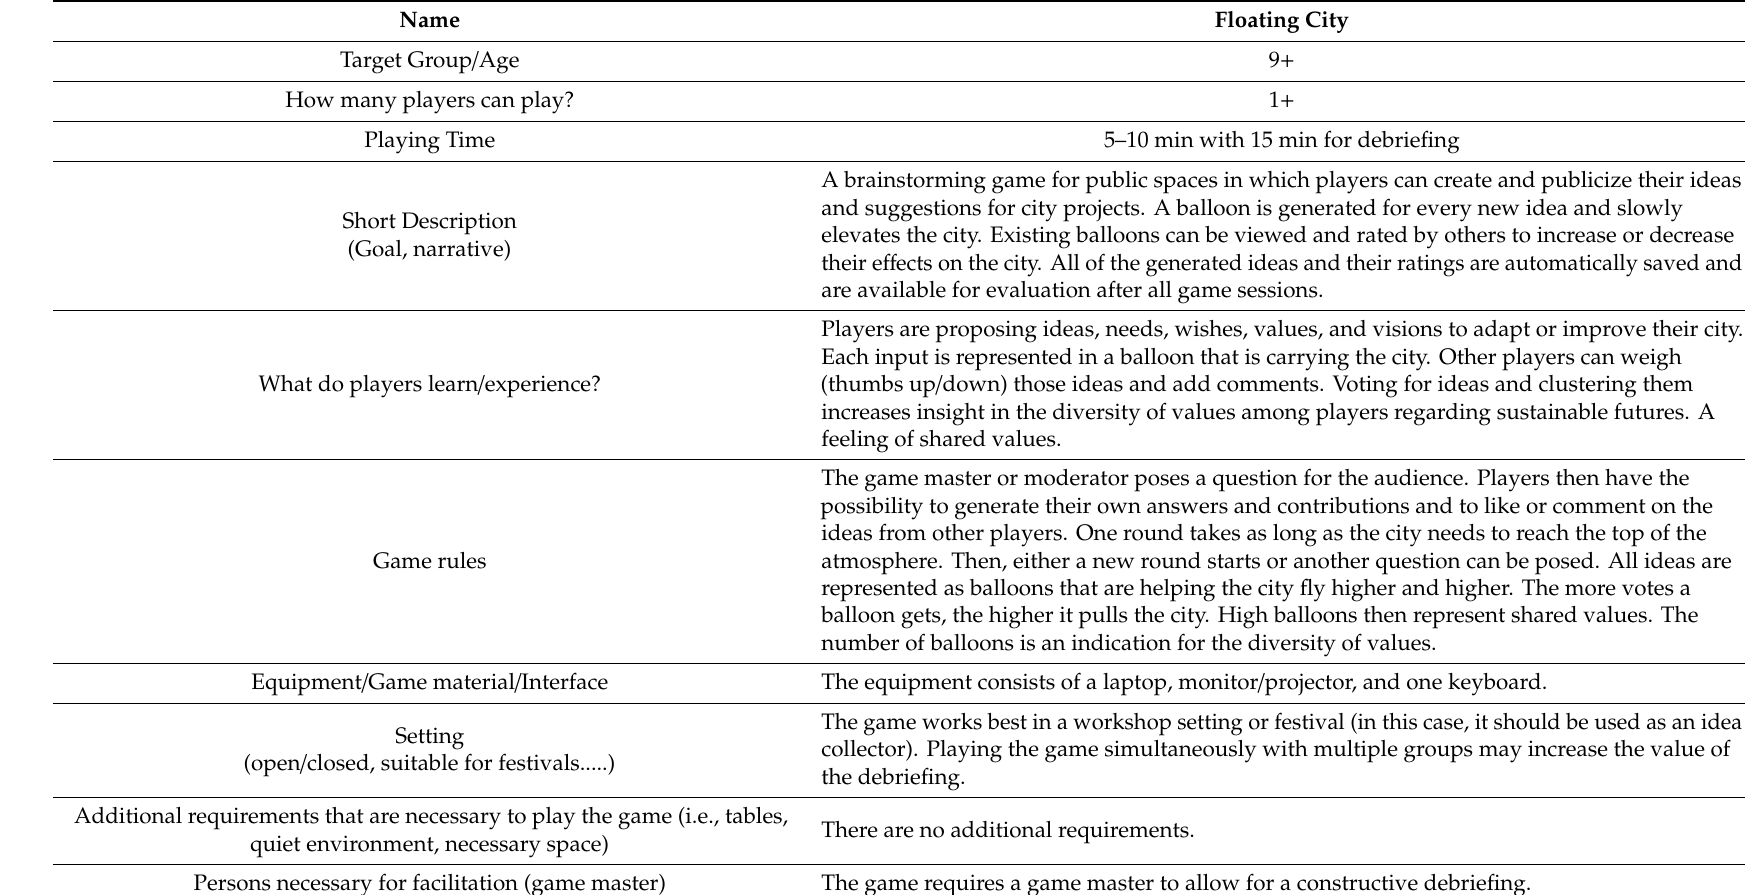
Table 3. Floating City—game